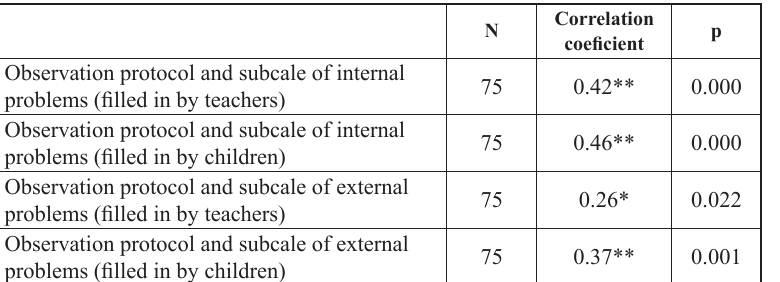
Table 2. Correlation between checlist and subcales of internal and external